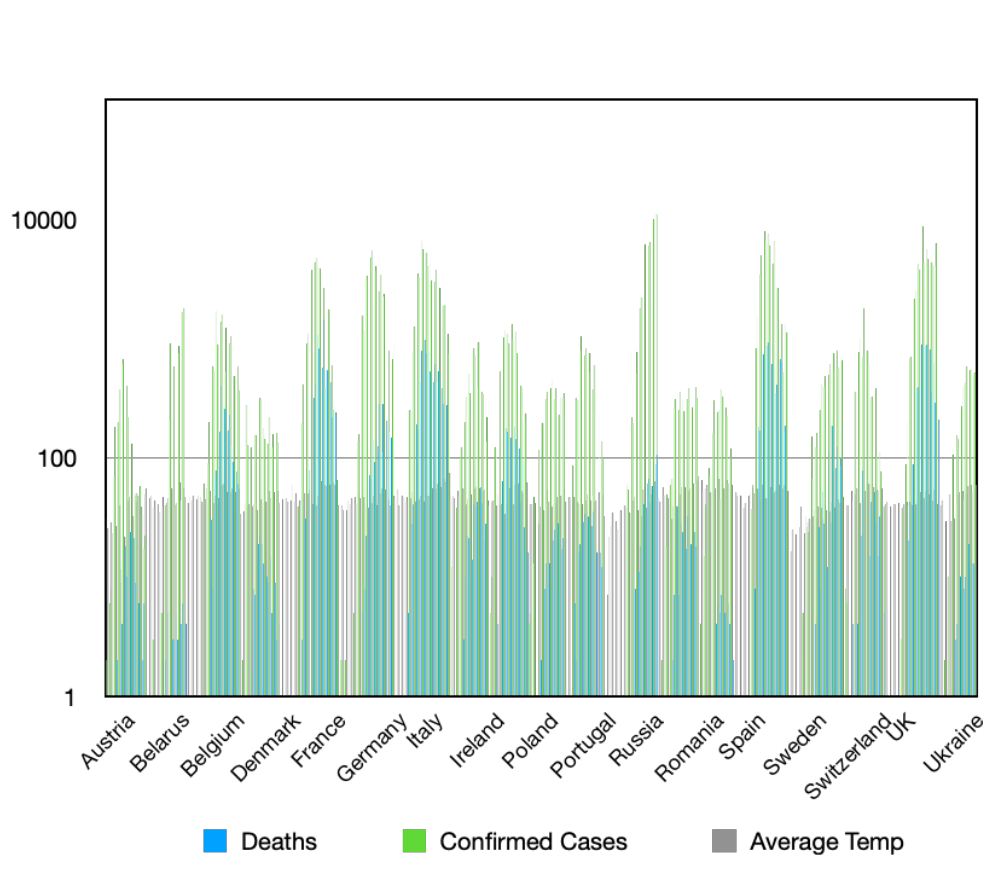
Fig. 9. Drivers of COVID-19 mortality in